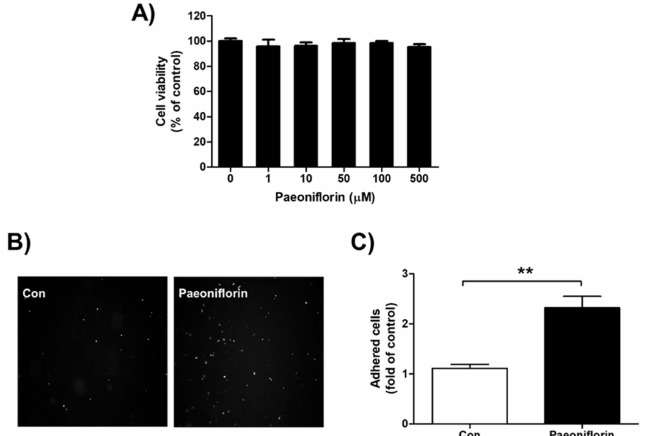
Figure 3. Cytotoxicity and effect of paeoniflorin on adhesion between endometrium and trophoblast. ( A ) Ishikawa cells were treated with 0, 1, 10, 50, 100, and 500 µ M paeoniflorin for 24 h. Viable cells were stained with 3-(4,5-dimethylthiazol-2-yl)-2,5-diphenyltetrazolium bromide (MTT) and the produced formazan was measured. Data were calculated as a percentage of control and are shown as the mean ± standard error of the mean (SEM). ( B ) Endometrial Ishikawa cells were treated with 50 µ M paeoniflorin for 48 h. Fluorescently labeled trophoblastic JAr cells were added to confluent Ishikawa cells. After incubation and washing, images of attached JAr cells were randomly captured, and representative images are shown. ( C ) The number of attached JAr cells was counted and calculated as a fold-change compared to control, and the results are shown as the mean ± standard error of the mean (SEM); ** p < 0.01 compared with